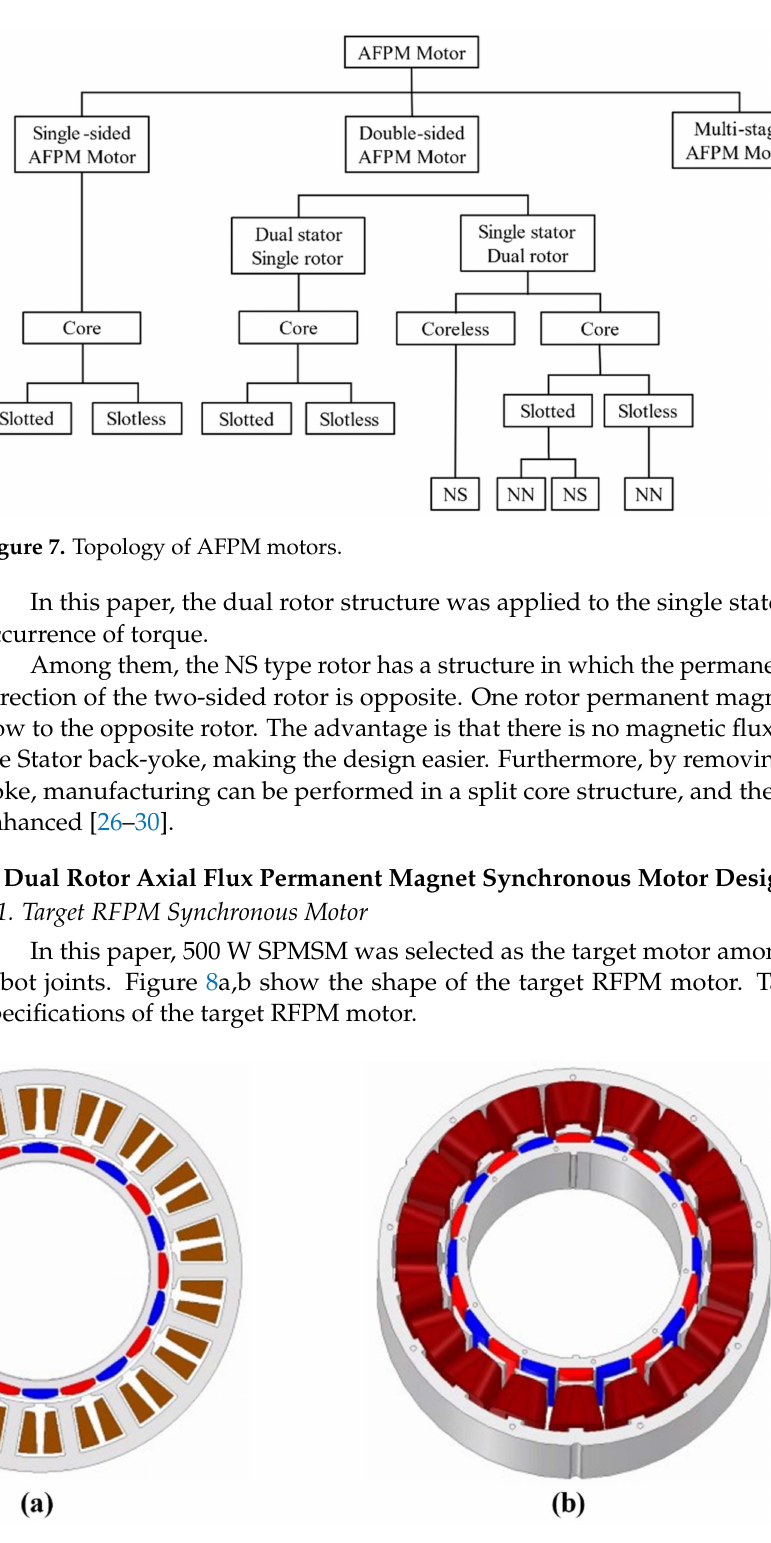
Figure 8. ( a ). 2D shape of target RFPM motor; ( b ) 3D shape of target RFPM